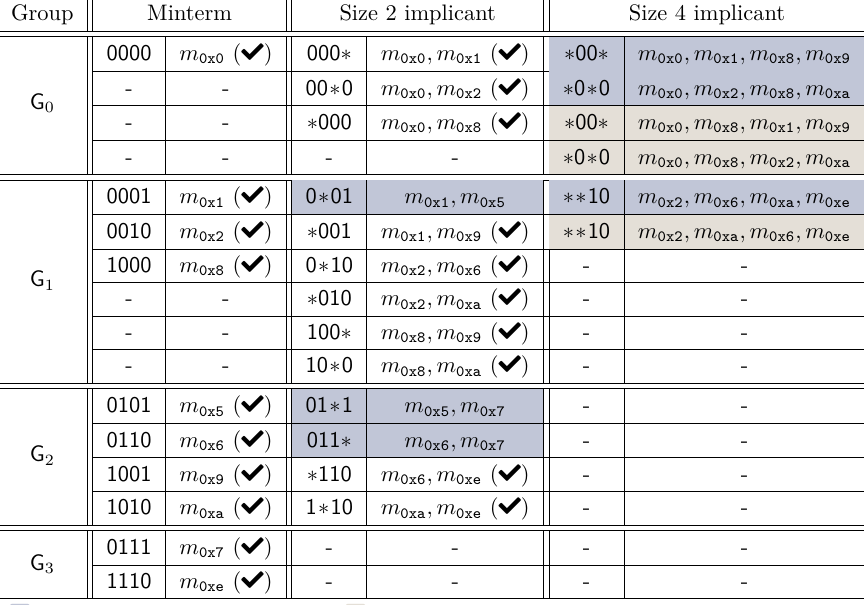
Table 1: Finding prime implicants of f